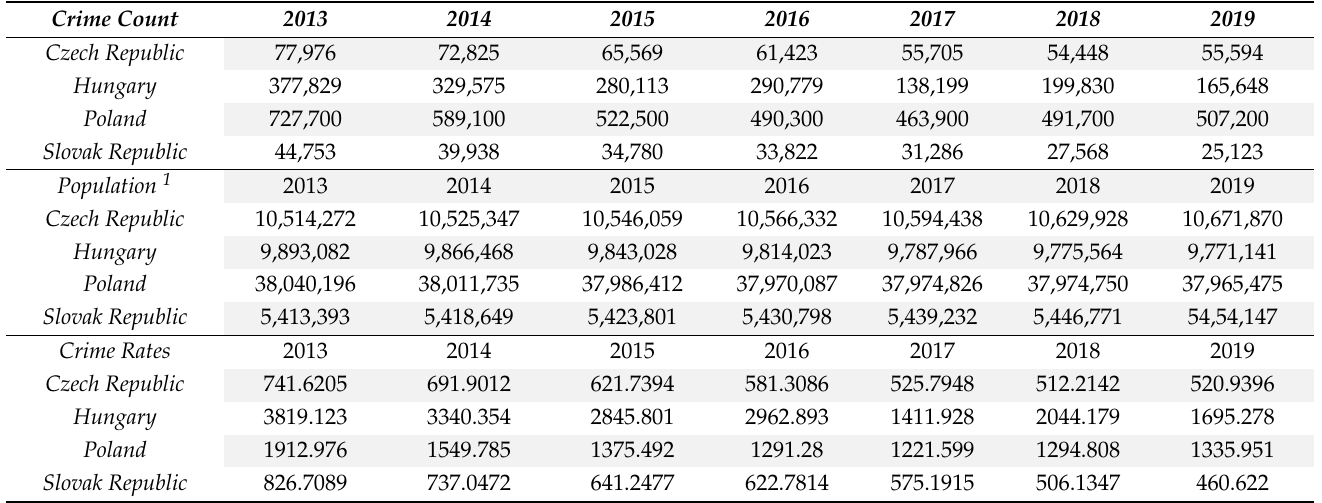
Table 2. Crime statistics, population data, and crime rates for the Czech Republic, Hungary, Poland, and Slovakia.